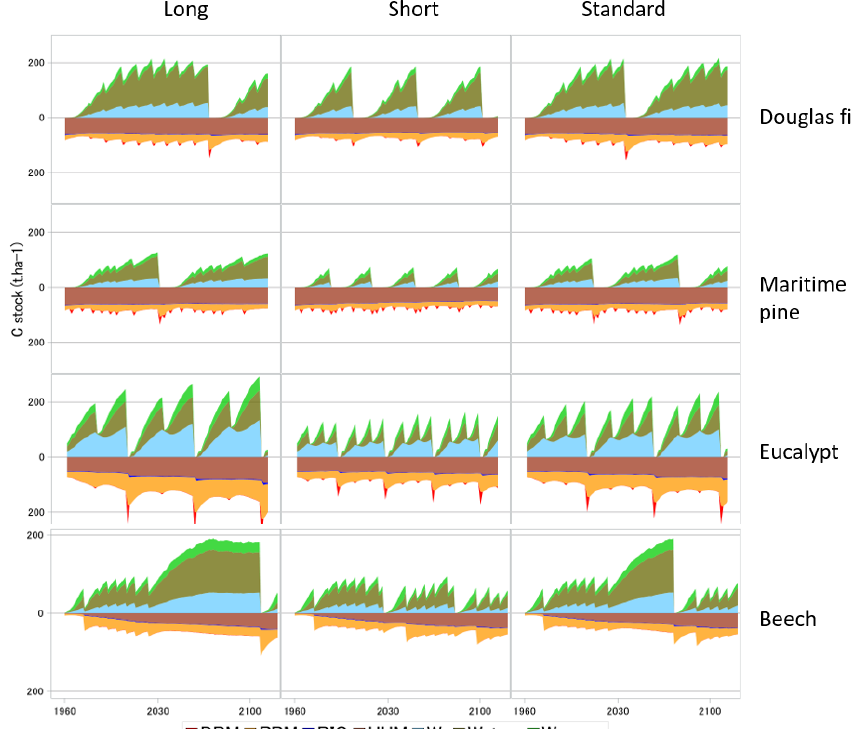
Figure 5. Biomass and soil carbon stocks simulated for four species and three management alternatives. The simulations were forced by the RCP 2.6 climate scenario. The grid point location is close to the centre of the French geographical distribution of each species. The pine and Douglas fir are grown in plantations managed with thinning rules and a final clear-cut based upon the mean stem diameter. Harvested parts are the stem only (Long) or crown and stem (Short and Standard). The eucalyptus is managed as a coppice with two cuttings of sprouts before new planting. The stump age is used to trigger coppicing and final cut. The beech stand is managed according to the relative density index (Le Moguedec and Dhôte, 2012). In the examples shown, the beech stand simulated was regenerated on a bare soil with low organic matter content and no understorey. In the legend, DPM, RPM, HUM and BIO are soil carbon pools of the decomposable, resistant, humified and biological parts, respectively. W r , W stem and W crown stand for the root, stem and branch + foliage carbon pools, respectively. The soil fractions “BIO” and “DPM” have low values that are barely